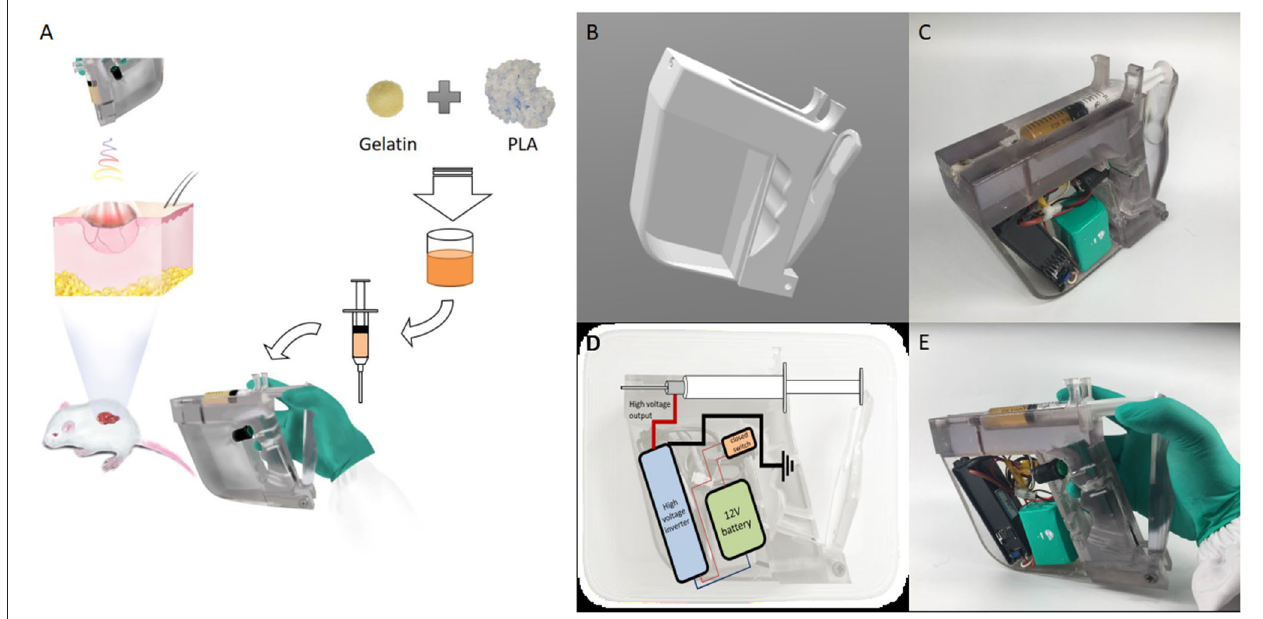
FIGURE 1 | The handheld electrospinning device. (A) A schematic diagram of the working state; (B) CAD design of the 3D printed device; (C) The device after installation; (D) Circuit design of the handheld electrospinning device; (E) Working posture of the handheld electrospinning device.